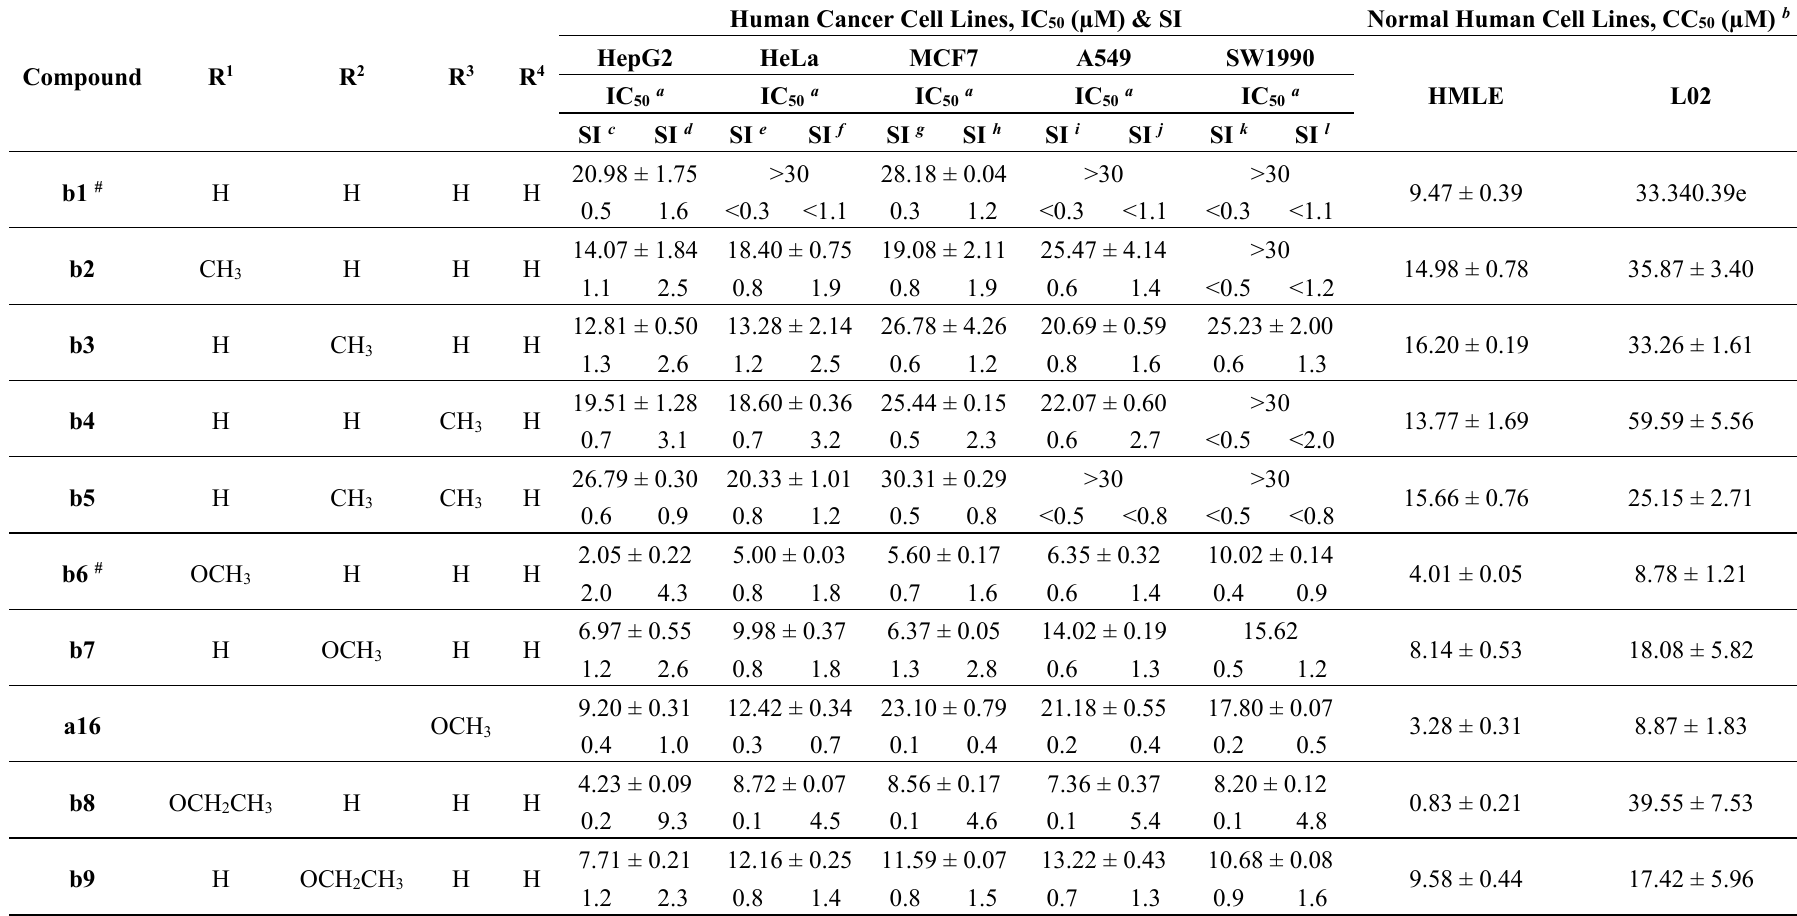
Table 2. Cytotoxicities of the 2',6'-dimethoxyl chalcones b1 – b42 against five human cancer cell lines and two non-tumoral cell lines.